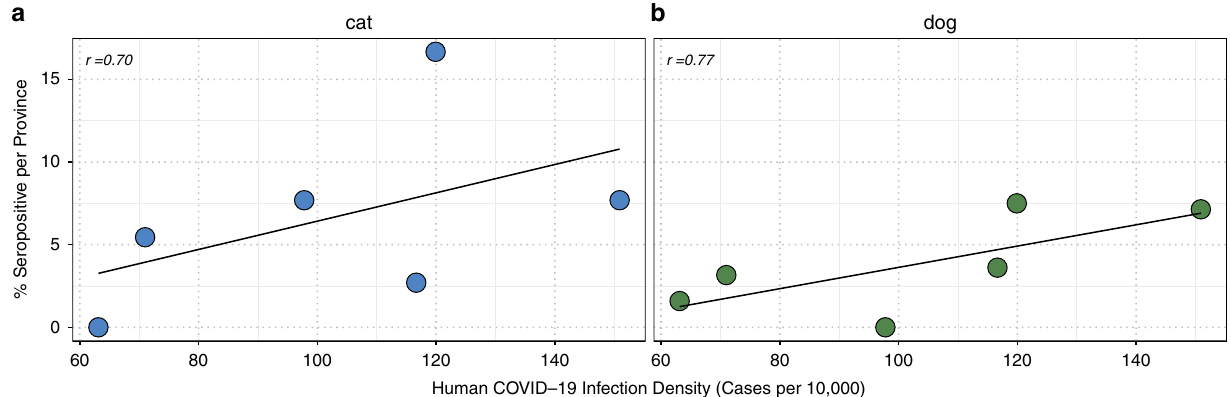
Fig. 2 Correlation of percentage of seropositive animals per province and human COVID-19 infection density in Lombardy. Data points were taken from provinces with at least ten samples. Spearman ’ s correlation was used to assess association. Source data are provided as a Source Data fi